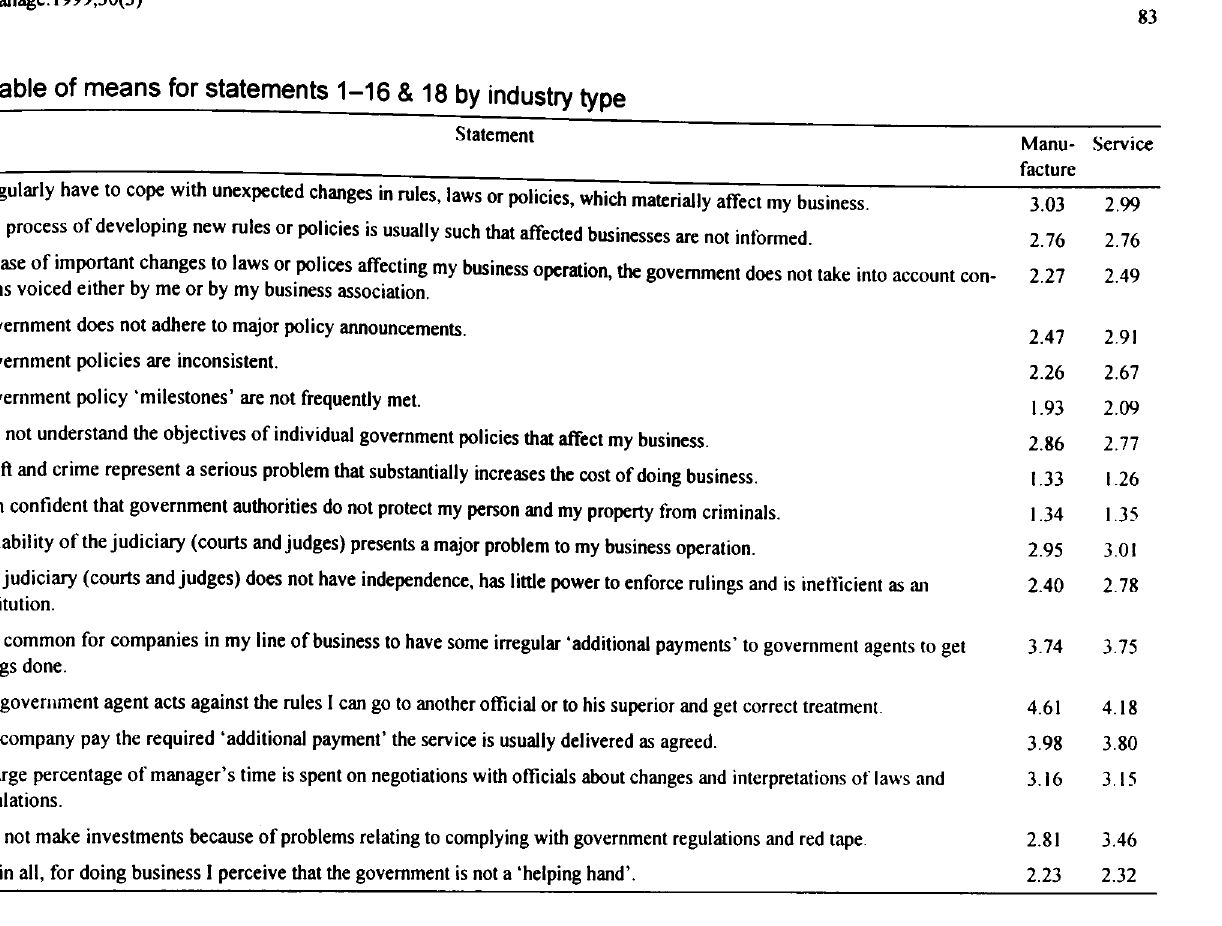
Table 5 Table of means for statements 1-16 & 18 by industry